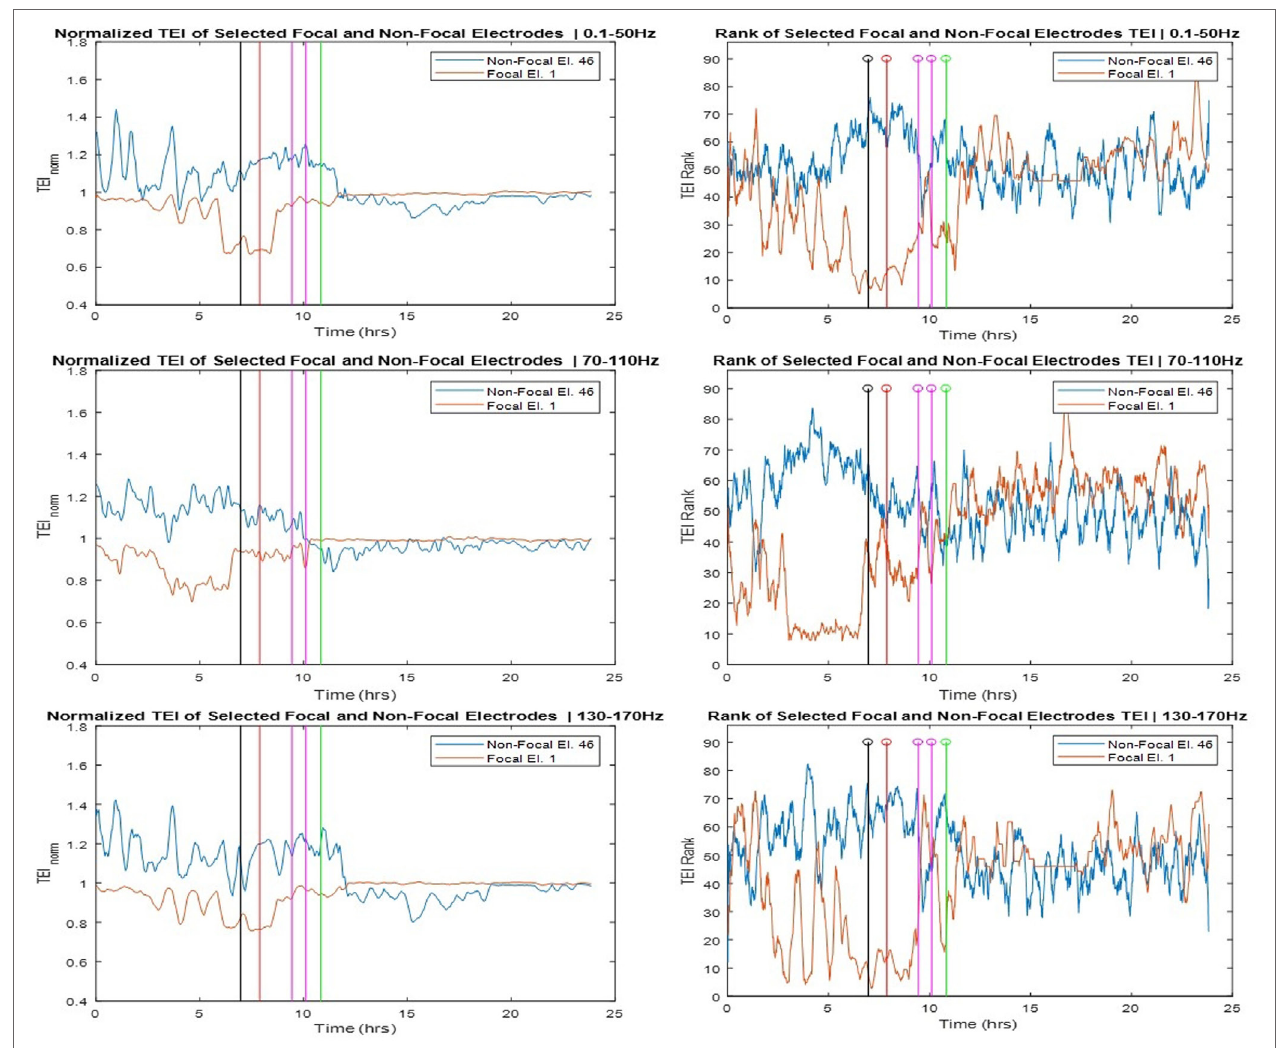
FigUre 5 | Left panels: Normalized total effective inflow (TEI norm ) profiles over time at one focal (Elec. 1) and one non-focal (Elec. 46) brain site for three frequency bands (low frequency band top, high frequency band middle, and ultrahigh frequency band bottom panels—see text for more details). Right panels: Rank of the focal and non-focal electrode in terms of their TEI norm values over time for the same three frequency